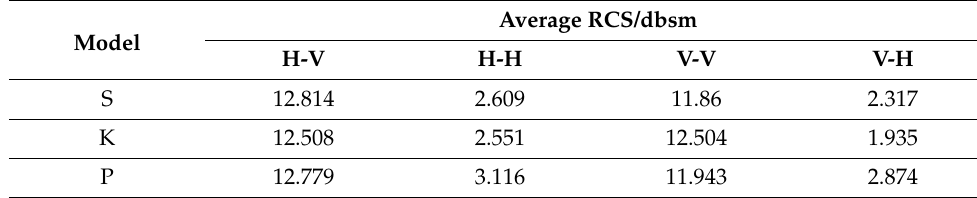
Table 6. Average RCS values of three models.